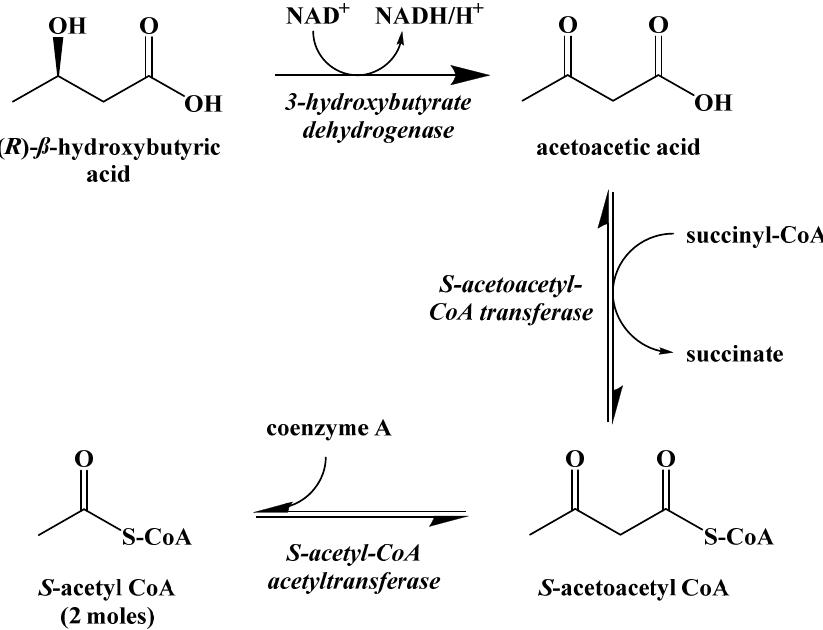
Figure 13. Ketolysis of the Ketone